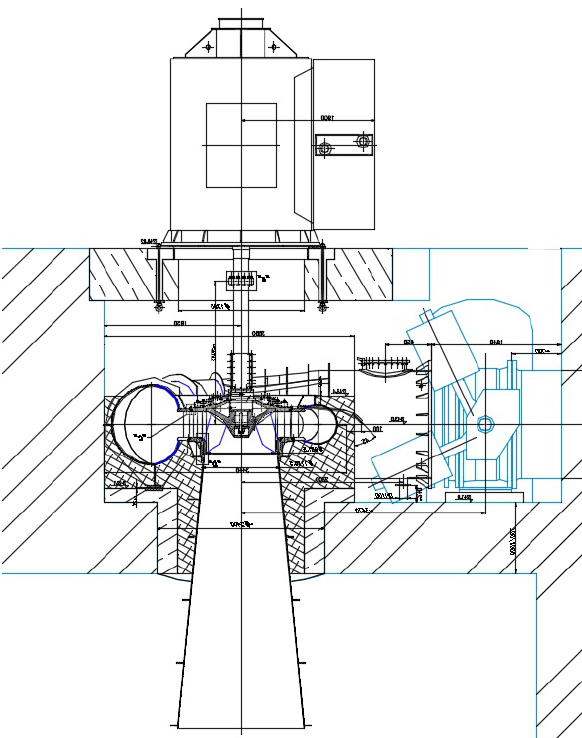
Figure 1: The object of analysis